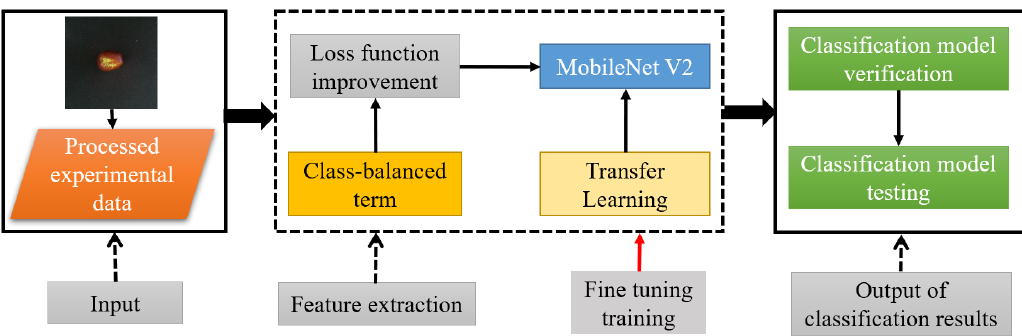
Figure 2. Flowchart of CB-MobileNet V2.